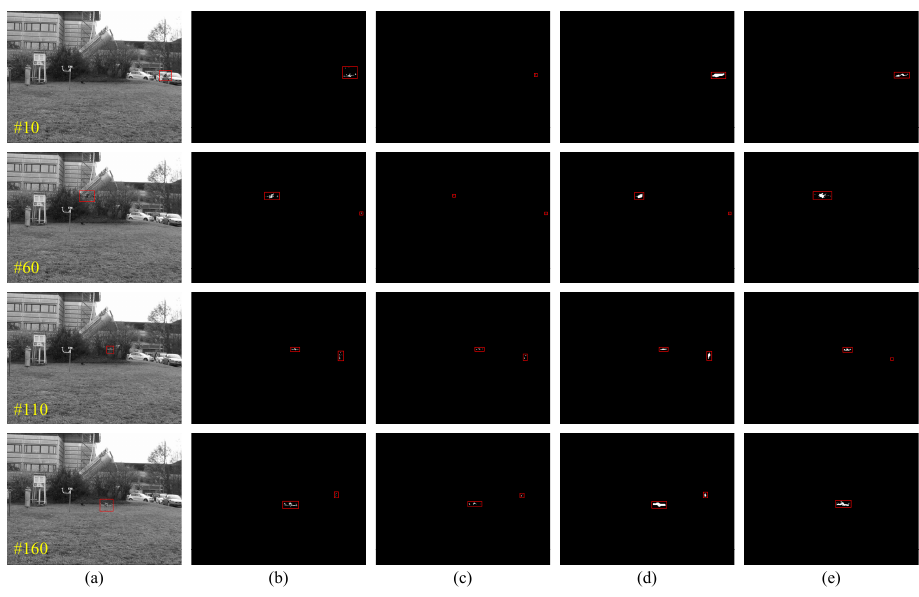
Figure 4. Some experiment results of flying small target detection on visible image sequence obtained from different algorithms ( a ) groundtruth, ( b ) GMMv1, ( c ) GRASTA, ( d ) DECOLOR and ( e ) the proposed method.